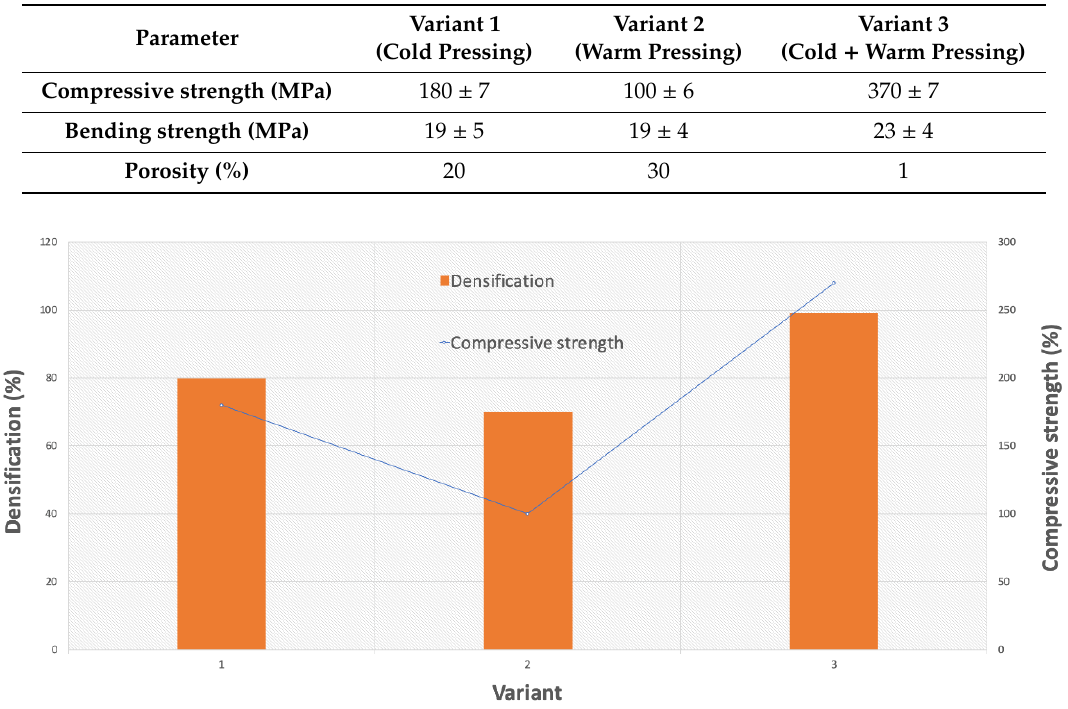
Figure 5. Comparison of three variants of forming, their impact on densification and porosity.